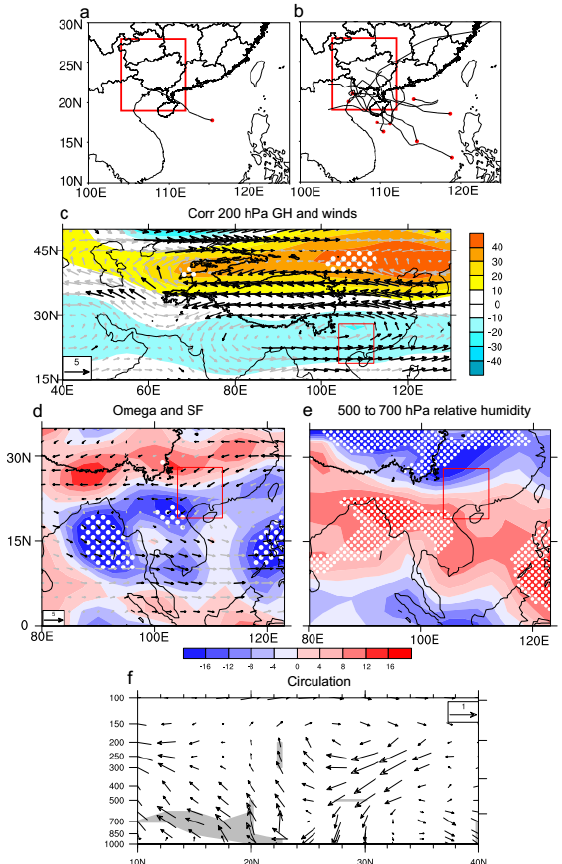
Figure 3. ( a ) The tracks and genesis locations of the TCs during the positive RSTP years. ( b ) Is the same as ( a ), but for negative RSTP years. Composite differences in ( c ) 200 hPa GH (shading) and wind (vector), ( d ) omega (shading) at average from 500 to 700 hPa and SF (vector), ( e ) relative humidity (shading) at average from 500 to 700 hPa, and ( f ) meridional to vertical cross to section of circulation averaged over 95° E – 108° E between the negative and positive RSTP years. The black vectors ( c , d ), white dots ( d , e ), and the shading ( f ) indicate the values significantly exceeding the 90% confidence level.